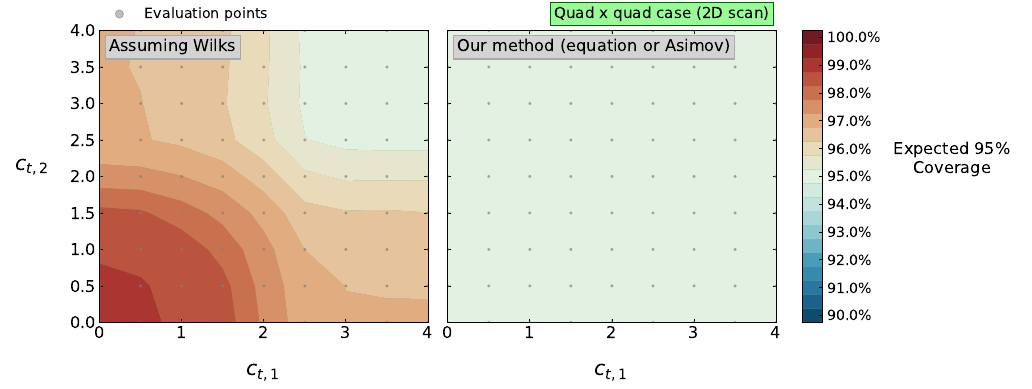
Figure 7: Expected 95% coverage assuming Wilks (left) and using our method (right) = ( 0.5,0.1 ) , ¯ n = ( 0.4,0.4 ) and a strong positive corre- for a 2D example with ¯ n 1 2 lation of ρ = 0.83. Our method provides correct coverage for all c true